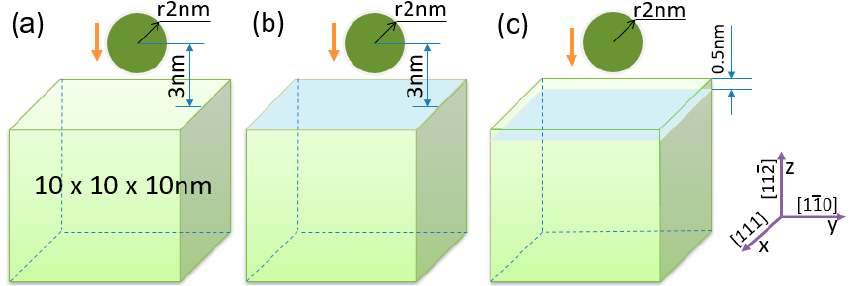
Figure 1. ( a ) Simulation cell of pure iron matrix; ( b ) simulation cell of composite with graphene on the surface of the matrix, the graphene could be monolayer, bilayer and trilayer; ( c ) simulation cell of composite with graphene in the superficial zone of the matrix, the graphene could be monolayer, bilayer and trilayer.